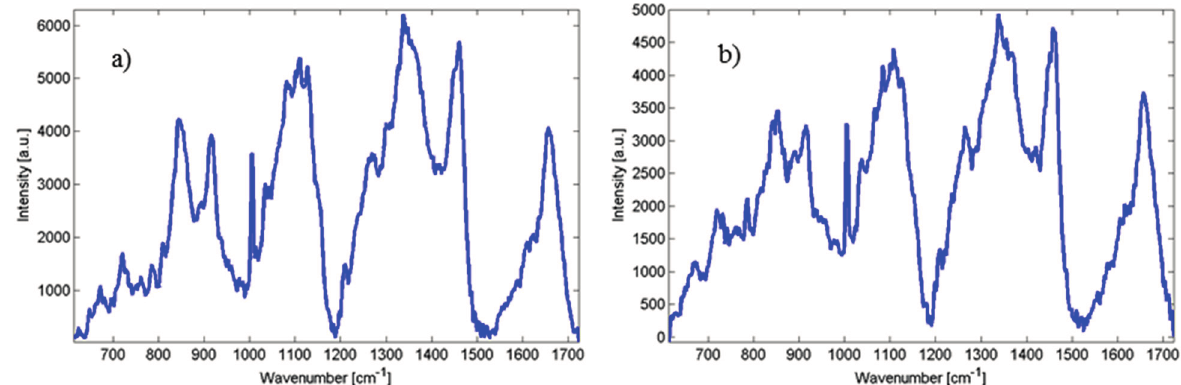
Figure 3. ( a ) Raman spectra of Candida orthopsilosis; and ( b ) Candida